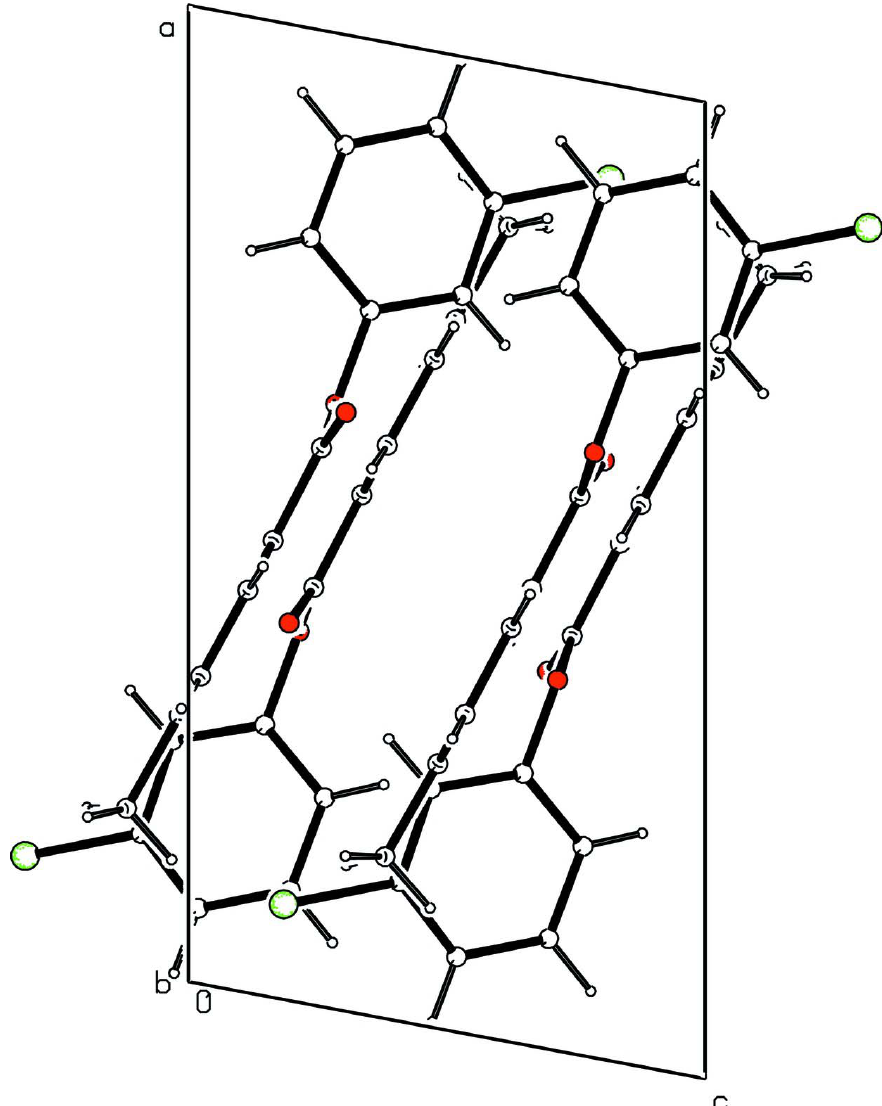
Molecular packing of the title compound. 3-Chlorophenyl